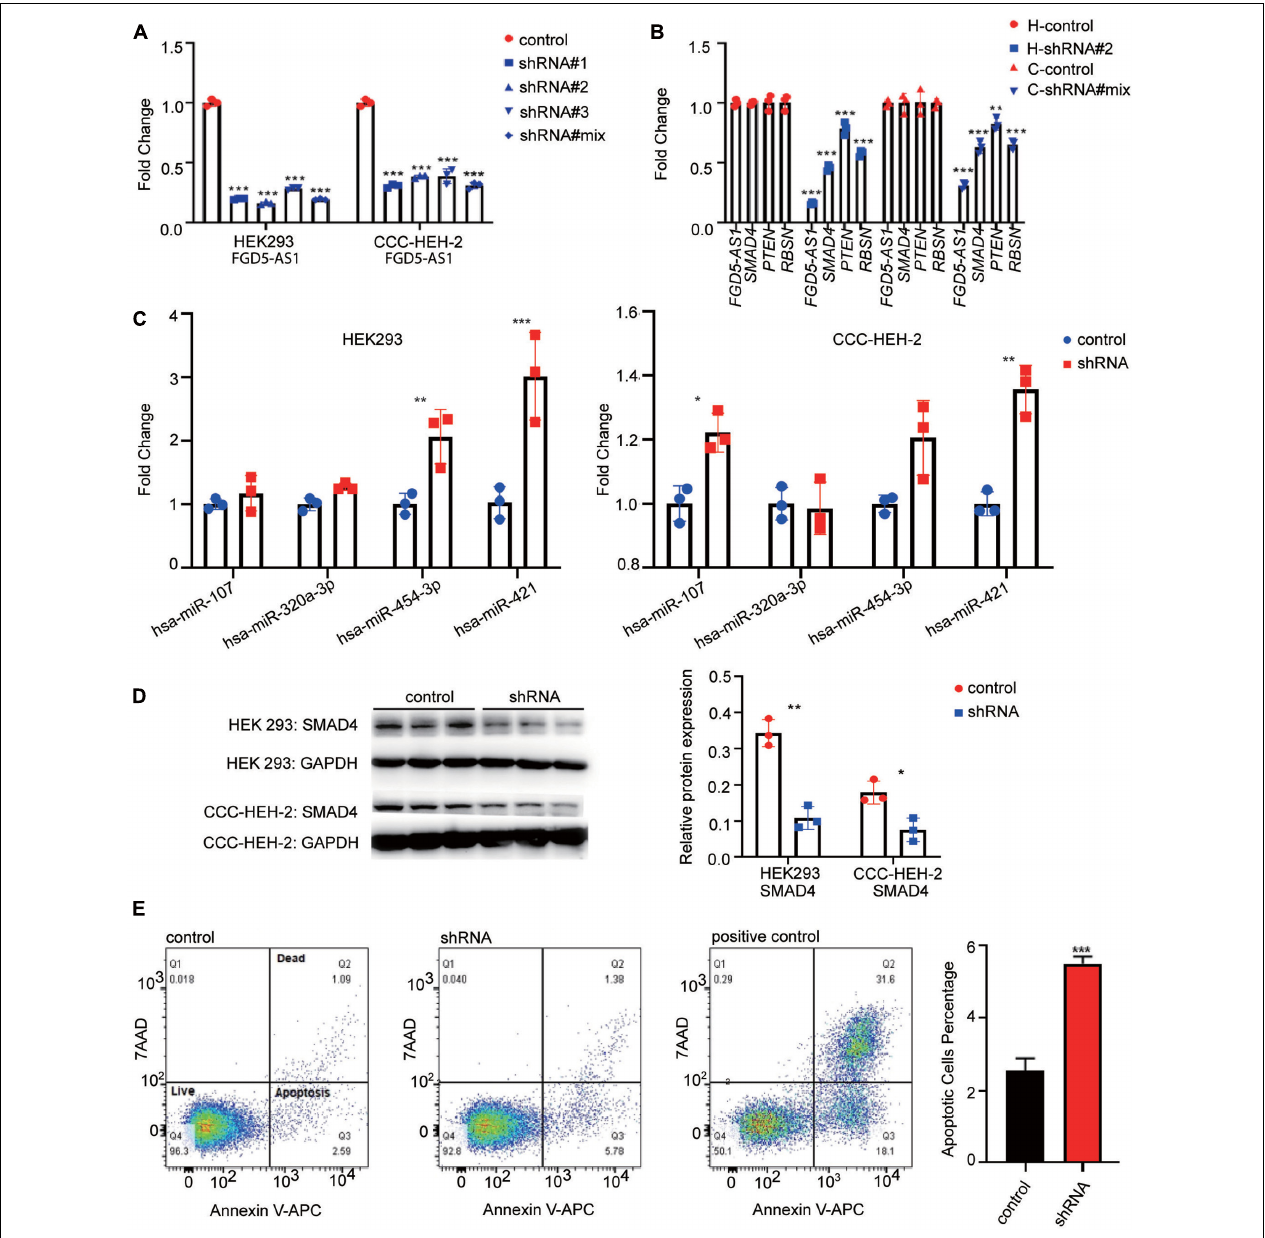
FIGURE 3 | lncRNA FGD5-AS1 suppressed the apoptosis. (A) Quantitative reverse transcription PCR (RT-qPCR) assays were performed to detect the interference efficiency of FGD5-AS1 in the HEK 293 and CCC-HEH-2 cell lines. (B) RT-qPCR assays suggested a decreased transcriptional level of mRNA ( SMAD4 , PTEN , and RBSN ) in two knockdowns (KD) of FGD5-AS1 cell lines ( H , HEK 293 cell line; C , CCC-HEH-2 cell line). (C) RT-qPCR assays of four miRs for previous validation in the FGD5-AS1 KD HEK 293 and CCC-HEH-2 cell lines. (D) Western blotting was used to verify that interfered FGD5-AS1 can affect the expression of SMAD4, and the relative protein expression was analyzed. (E) Flow cytometry was performed to detect apoptosis in the FGD5-AS1 KD CCC-HEH-2 cell line. The positive controls were CCC-HEH-2 cells treated with apoptosis induction drugs. n.s., not significant; The number of asterisks indicated the corresponding statistical significance ( p -value). * p < 0.05; ** p < 0.01; *** p <